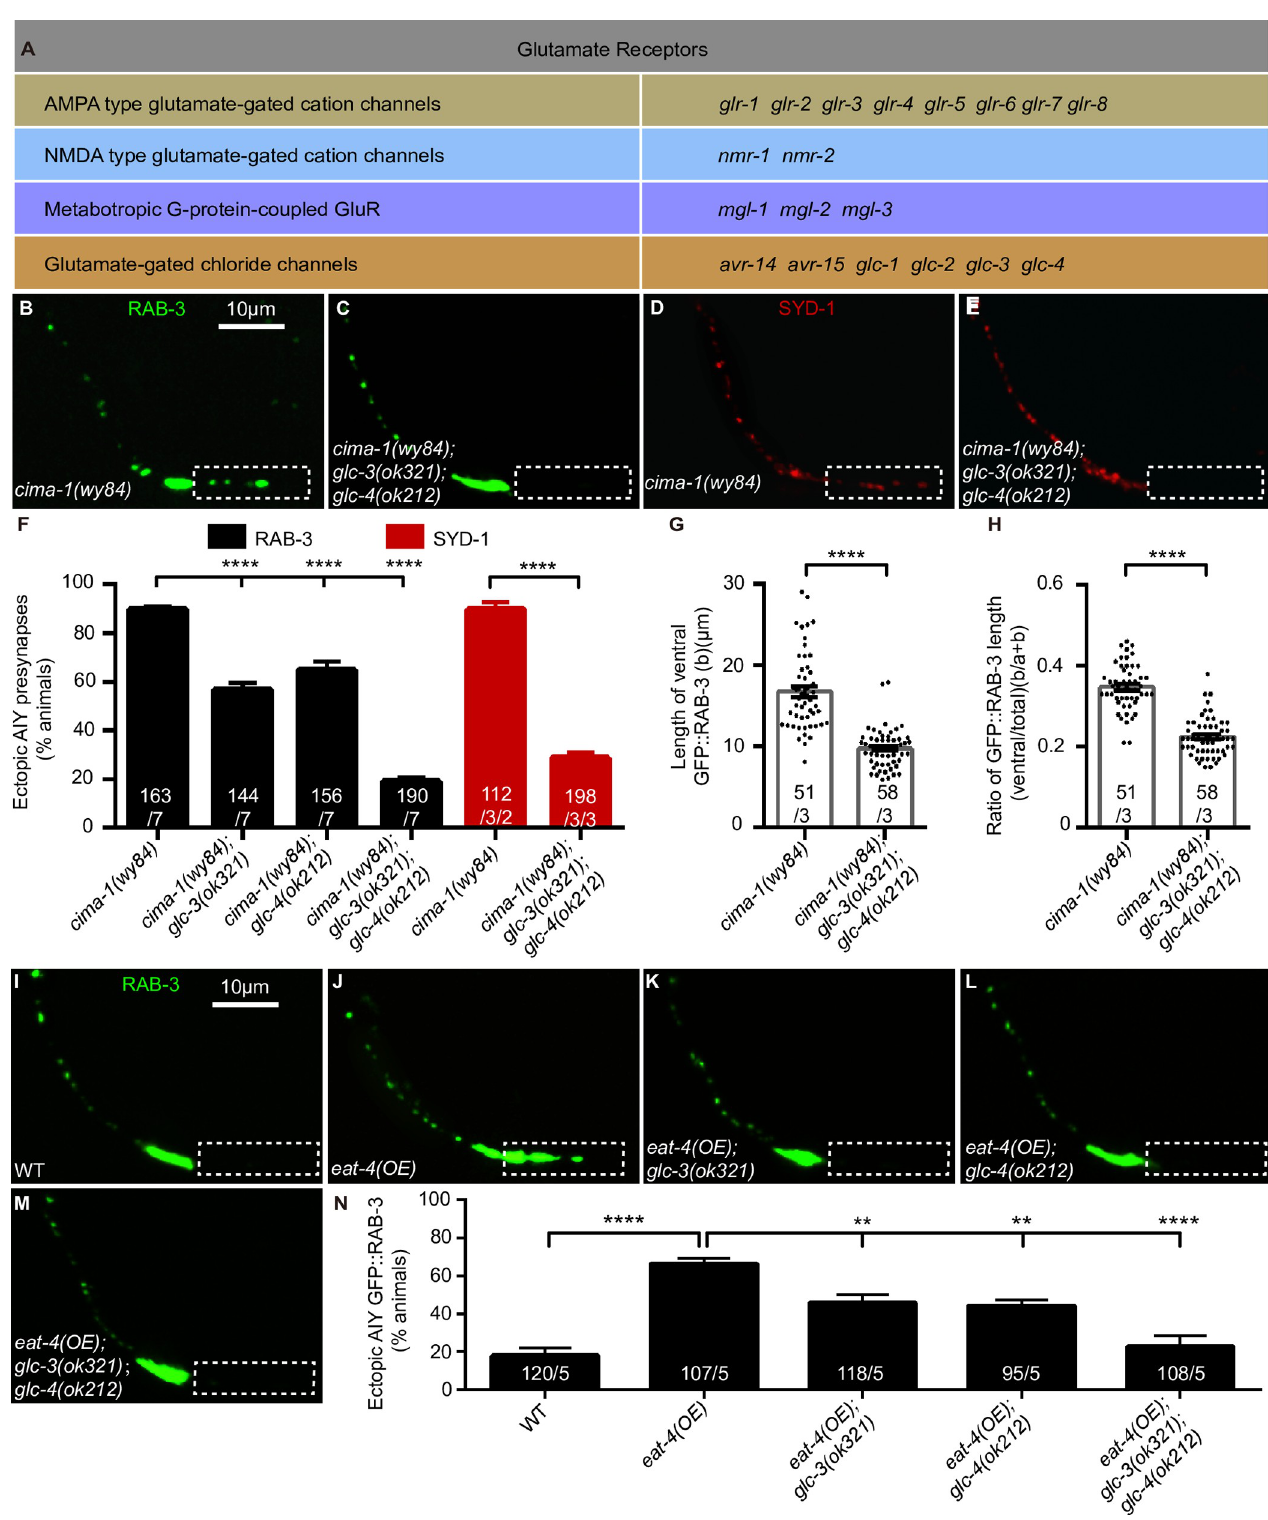
Fig 3. Glutamate-gated chloride channels GLC-3 and GLC-4 are required for the ectopic synaptic formation. (A) A list of genes encoding four type of glutamate receptors tested for the role in the ectopic synaptic formation: AMPA receptors, NMDA receptors, metabotropic glutamate receptors and glutamate- gated chloride channels. (B-E) Representative confocal micrographs of the AIY synaptic vesicle marker GFP::RAB-3 (B and C) or active zone marker SYD-1::